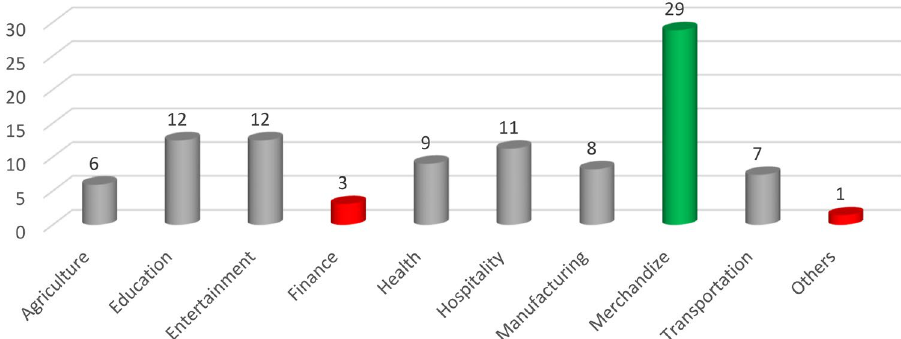
Fig. 7 General Analysis of SMEs’ Preference for Solar Energy. Source: Researchers’